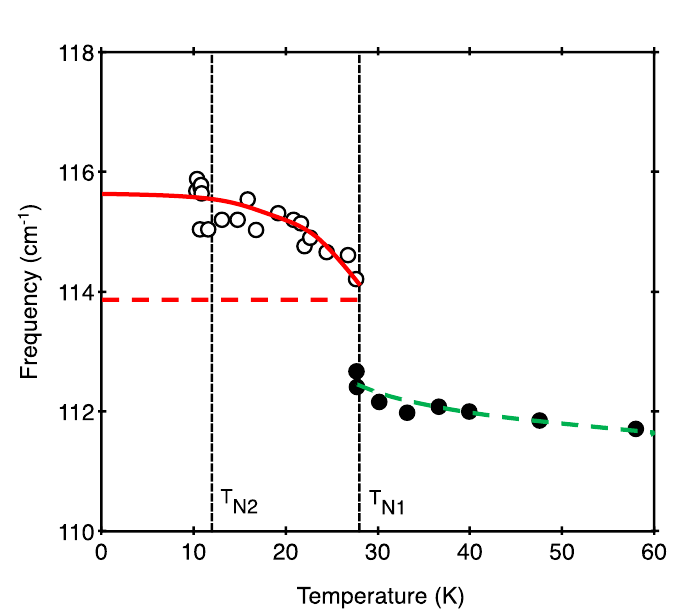
Figure 4. Temperature dependence of the E 1g mode frequency (data points) from Raman scattering measurements. The other lines are guides to the eye and are used in the theory (see the